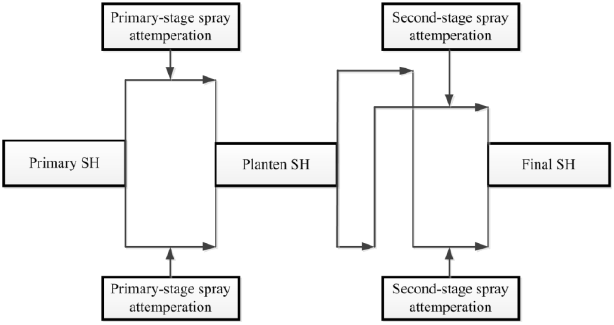
Figure 8. Arrangement of the two stage spray attemperation.